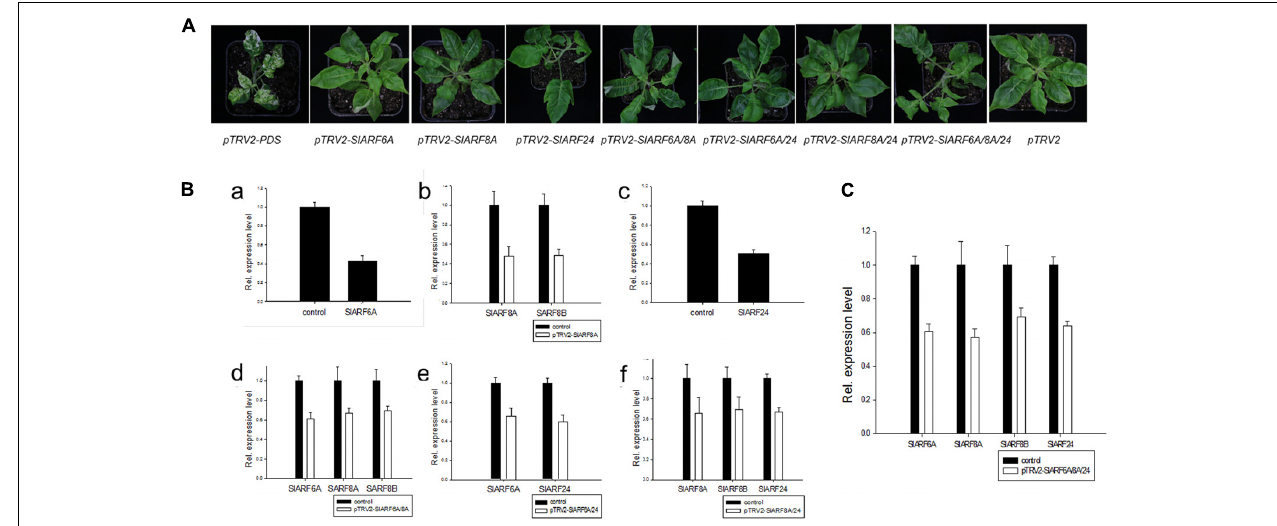
FIGURE 3 | TRV-mediated virus-induced gene silencing (VIGS) of candidate SlARF genes in tomato e mutation leaves. SlARF8A and SlARF8B shared the same gene fragment in the VIGS vector. (A) Photographs of silencing tomato e mutation. (B) The candidate SlARF genes expression of injected with pTRV2-SlARF6A (a) , pTRV2-SlARF8A (b) , pTRV2-SlARF24 (c) , pTRV2-SlARF6A/8A (d) , pTRV2-SlARF6A/24 (e) , pTRV2-SlARF8A/24 (f) cultures, respectively. (C) The SlARF genes expression of injected with pTRV2-SlARF6A/8A/24 culture. The expression of a specific SlARF was compared with the level in e mutant plant agroinfiltrated with empty vector (control sample). Standard errors (SE) are shown ( n =